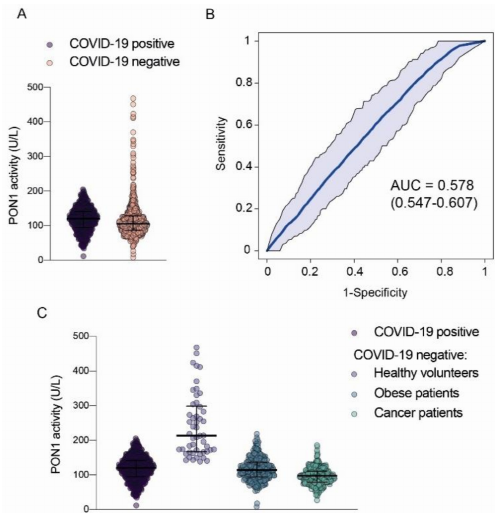
Figure 4. Serum paraoxonase-1 (PON1) activities in COVID-19-positive patients and all COVID- 19-negative patients (obesity + cancer) and healthy volunteers combined ( A ); Receiver Operating Characteristics (ROC) curves comparing COVID-19-positive patients and COVID-19-negative patients ( B ); Serum paraoxonase-1 (PON1) activities in COVID-19-positive and COVID-19-negative patients separated according to their disease ( C ). AUC: Area under the